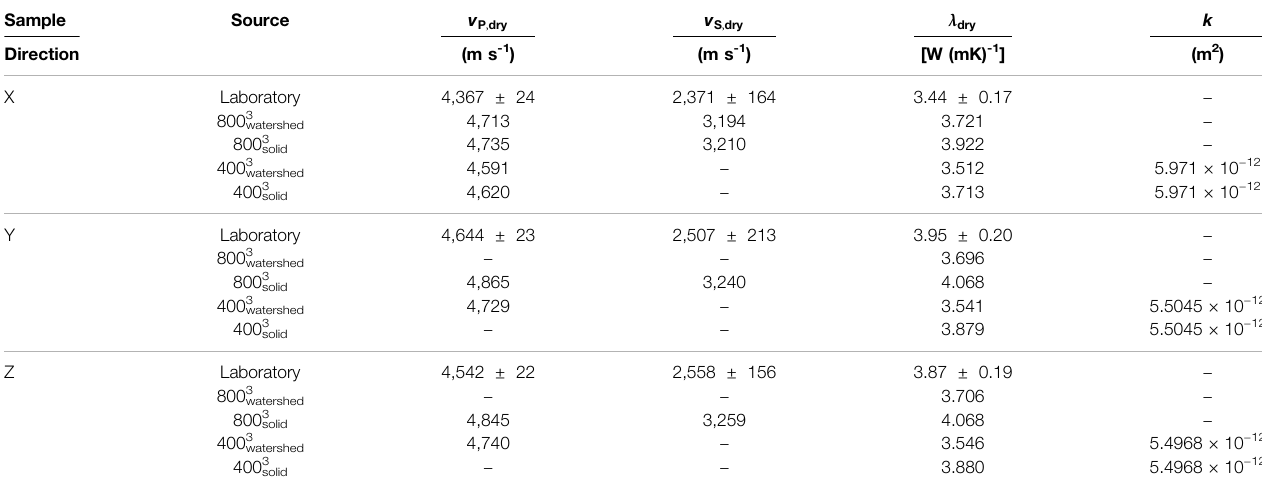
TABLE 5 | Correlation between laboratory and numerical derived